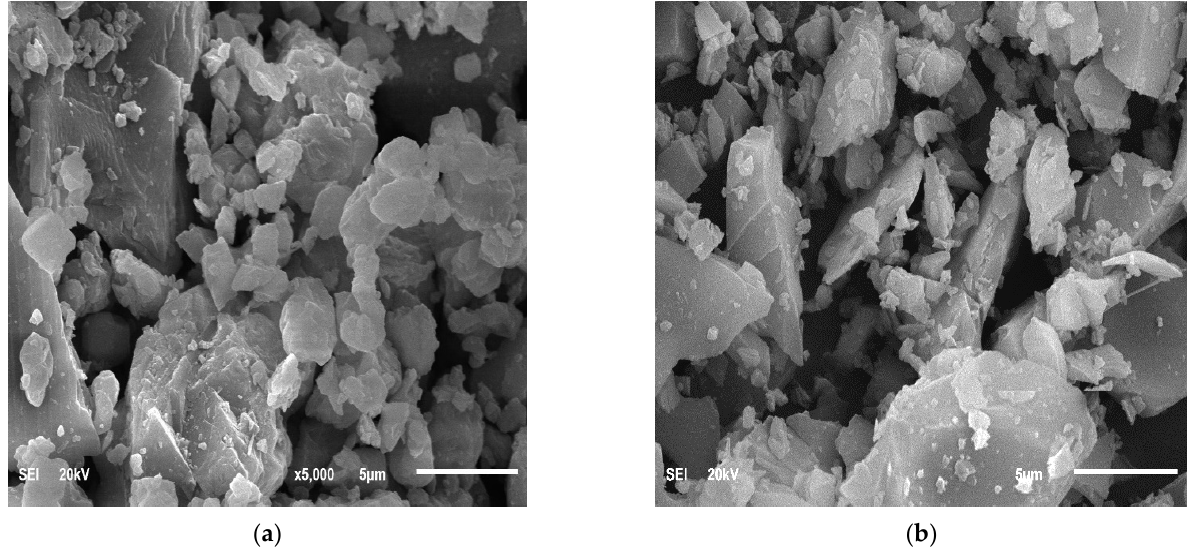
Figure 2. SEM images of ( a ) Raw limestone powder ( b ) Raw volcanic powder.